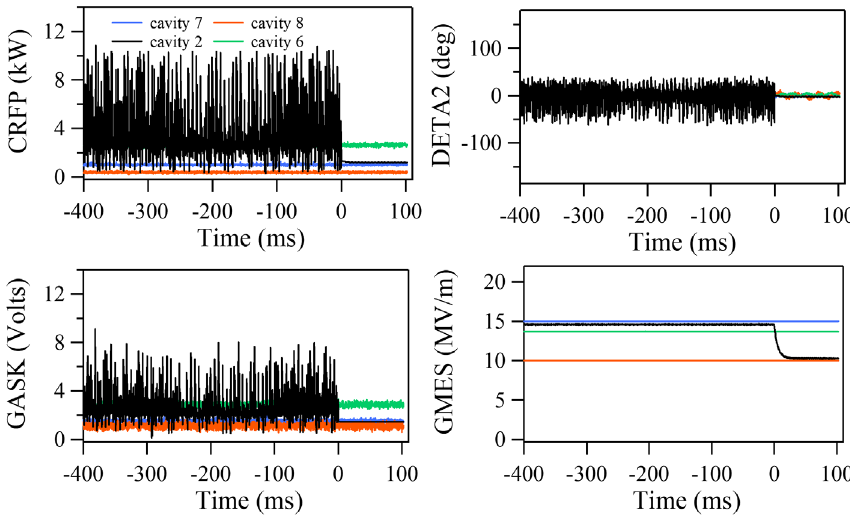
FIG. 11. Waveforms for a controls fault. The plots display the forward power (top left), detune phase angle (top right), a digital signal proportional to the drive voltage (bottom left), and the measured gradient (bottom right). Only four of the eight cavities are plotted for clarity. Note that the scale of the horizontal axis has been modified to begin 400 ms before the fault